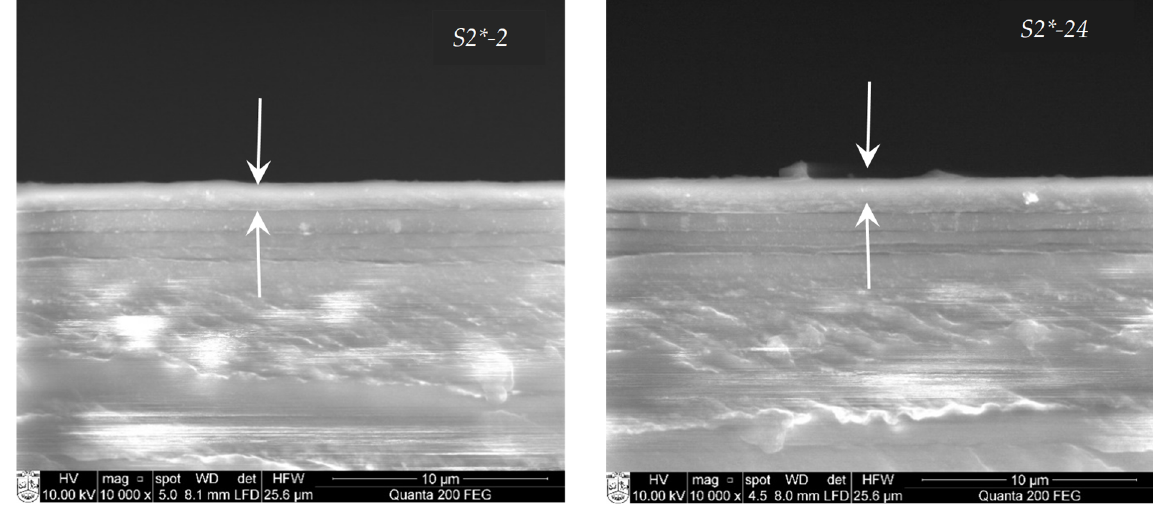
Figure 7. SEM images of cross-sections of cadmium chalcogenide layers on PA 6.